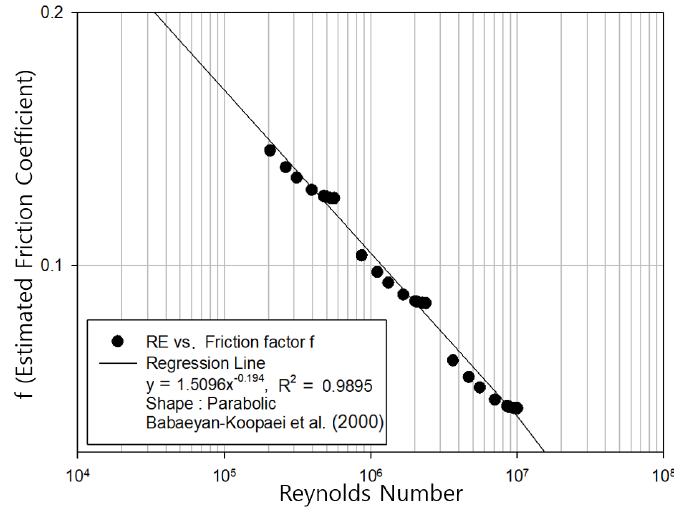
Figure 5. The relationship between (cid:1858) and (cid:1844)(cid:1857) calculated using Yuen’s data.